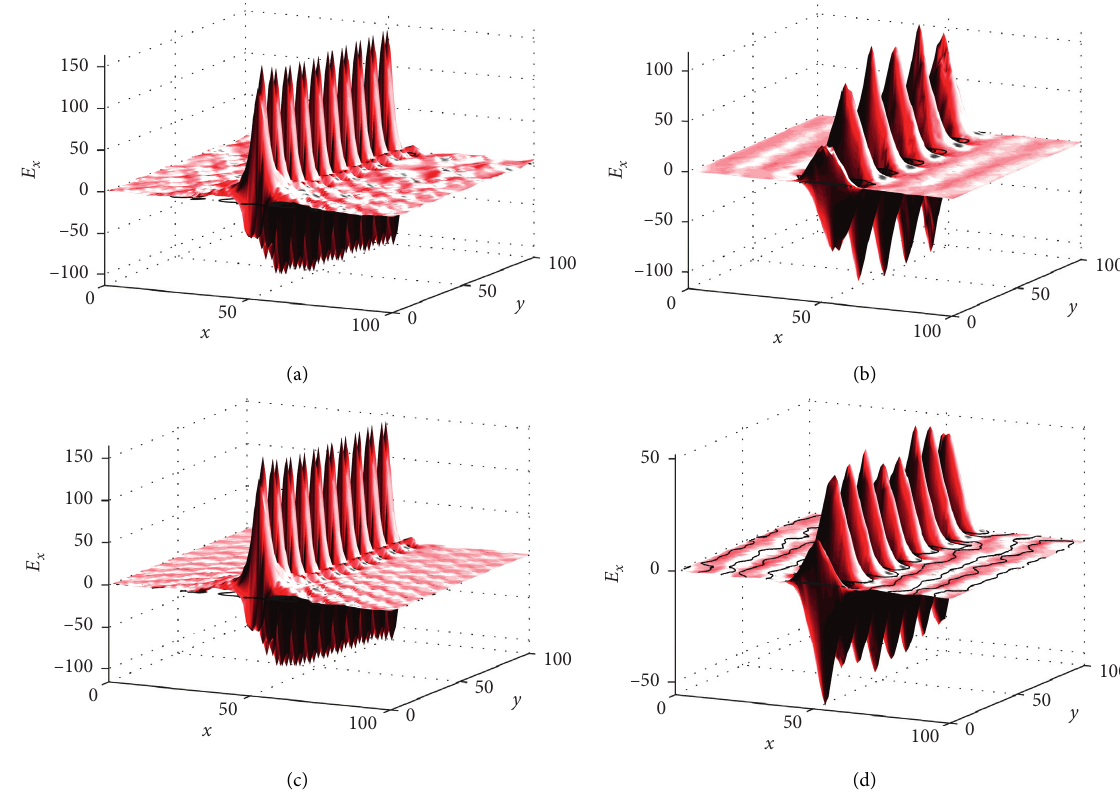
Figure 6: (Color on line) the spatial ( x, y ) shape of field component E frequencies. (a) v